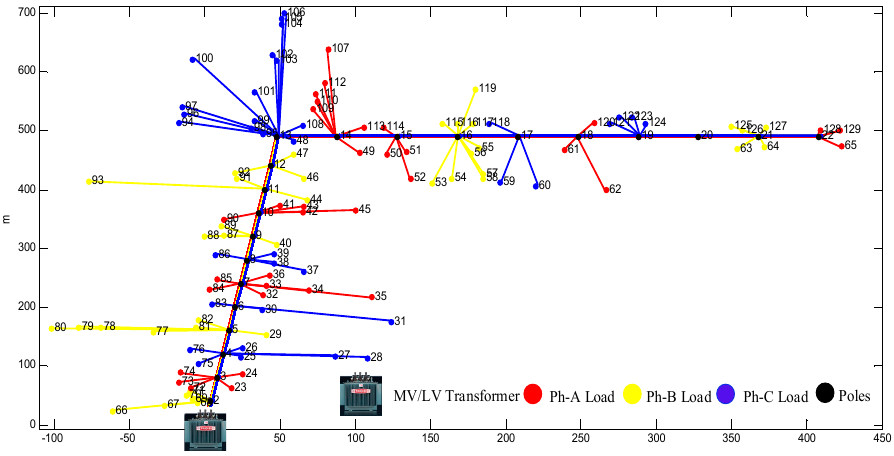
Figure 8. Optimal radial topology by SP-MIQP algorithm. The active power at each phase for the three different algorithms is given in Table 3.